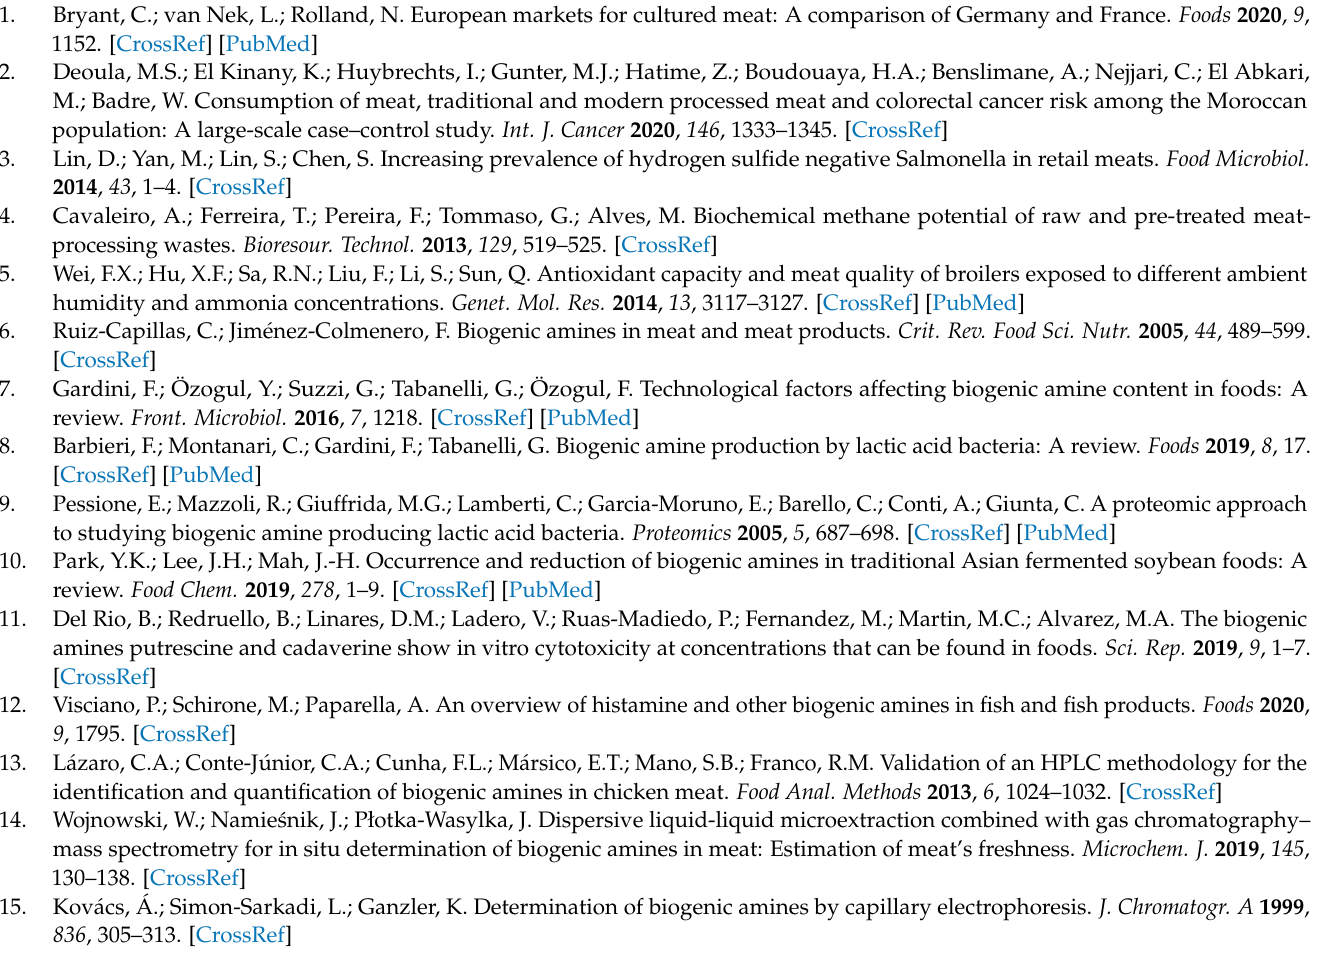
CS 2 , Figure S3: Changes in the plasmon spectrum of colloidal gold nanoparticles based colorimetric sensor for the detection of BAs in the absence of CS 2 , Figure S4: Changes in the plasmon spectrum of colloidal gold nanoparticles based colorimetric sensor for the detection of BAs in the presence of CS 2 , Figure S5: Visual analysis of colloidal gold nanoparticles based colorimetric sensor in the absence of CS 2 for the detection of mixed BAs, Figure S6: Changes in the plasmon spectrum of colloidal gold based colorimetric sensor in the absence of CS 2 for the detection of mixed BAs, Figure S7: Changes in the plasmon spectrum of colloidal gold based colorimetric sensor in the presence of CS 2 for the detection of mixed BAs, Figure S8: Selectivity of colorimet-ric sensor with various molecules, Table S1: Comparison of various methods for detection of